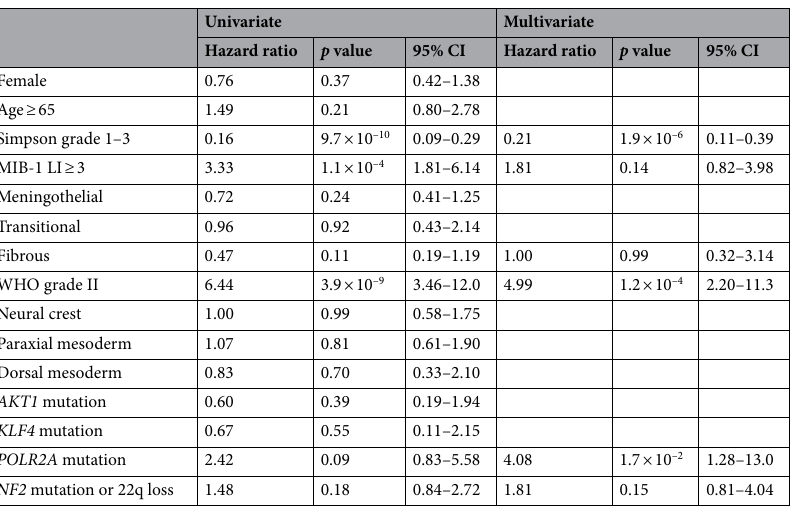
Table 2. Risk factors for tumor recurrence. LI indicates labelling index, ST-med supra-tentorial-medial, ST-ant/lat supra-tentorial-antero-lateral, ST-post/lat supra-tentorial-postero-lateral, CI confidence